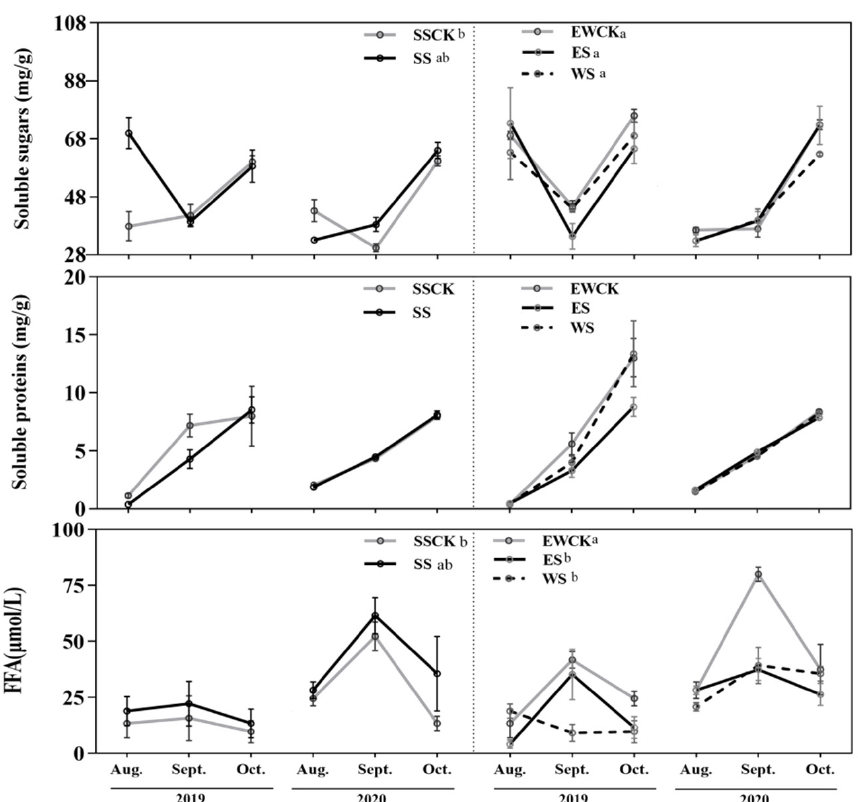
Figure 2. Foliar soluble nutrients of tea plants under intercropped maize ecological shading ( Note: SSCK, SS, EWCK, ES, WS with at least one identical letter are not significant different from each other by the LSD test at p >0.05. The same as in the following figures).